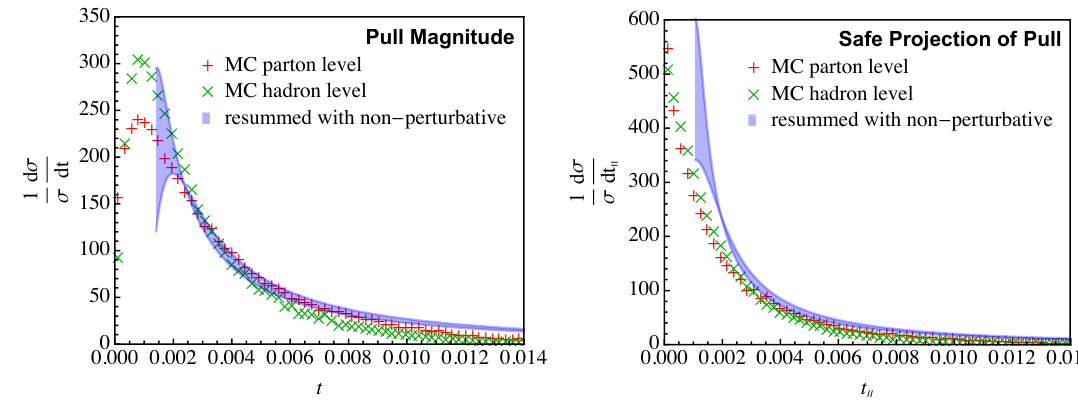
Figure 4 . Comparison of the distributions computed at NLL and supplemented with